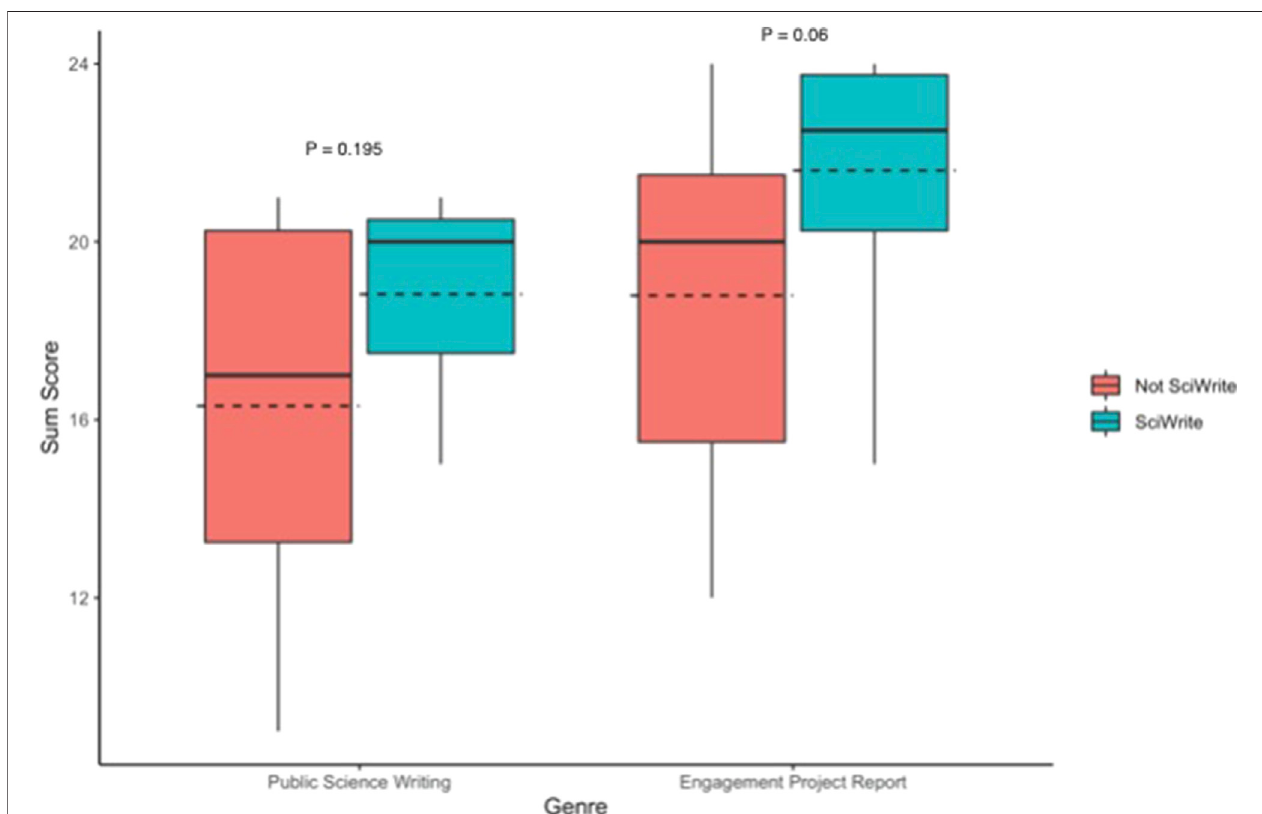
FIGURE 5 | Box and whisker plot of SciWrite versus non-SciWrite total score for the Public science writing piece and Public engagement project report. For the public science writing pieces, minimum possible score was eight and maximum possible score was 21. For the public engagement project reports, minimum possible score was eight and maximum possible score was 24. Boxes show 50% of the values for reported scores, solid lines within boxes show median score, dashed lines show mean score, whiskers show minimum and maximum reported scores. P -values are from a Mann-Whitney U test comparing scores of SciWrite versus non- SciWrite students for each of the two